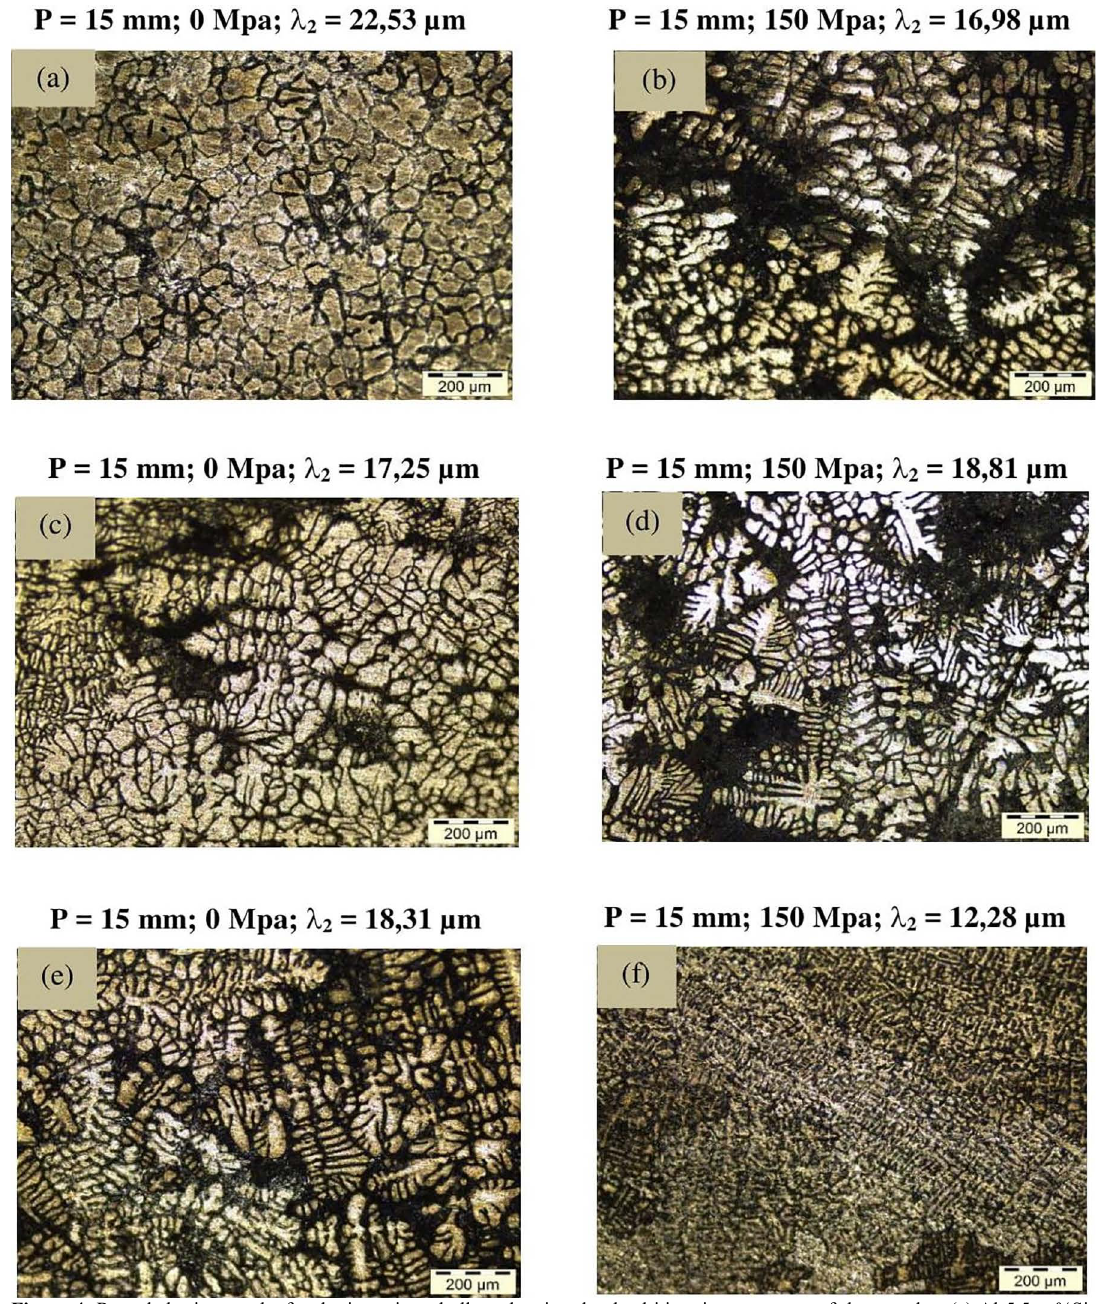
Figure 4. Revealed micrographs for the investigated alloy, showing the dendritic microstructures of the samples: (a) Al-5.5wt.%Si- 3.0wt.%Cu (b) Al-7.5wt.%Si-3.0wt.%Cu and c) Al-9wt.%Si-3.0wt.%Cu. According to Runxia Li in his study for alloys Al-xSi (x = 15, 17.5 and 22 wt%) solidified under pressure of 600 MPa the increase of the silicon concentration in the alloy, as well as the use of high pressure, caused a greater refinement of the structure and consequently an increase in microhardness of 15.91%, 12.23% and 17.48% with respect to gravity casting 22